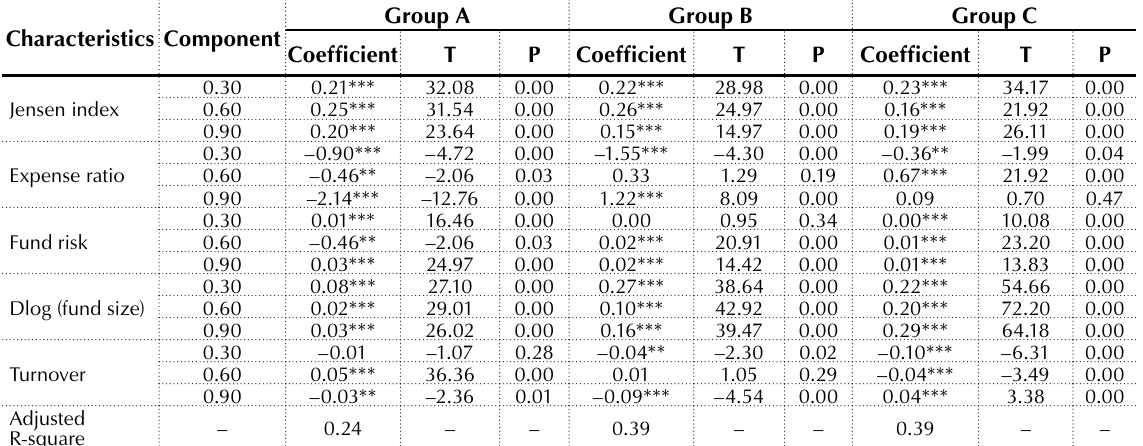
Expense ratio Fund risk Dlog (fund size)